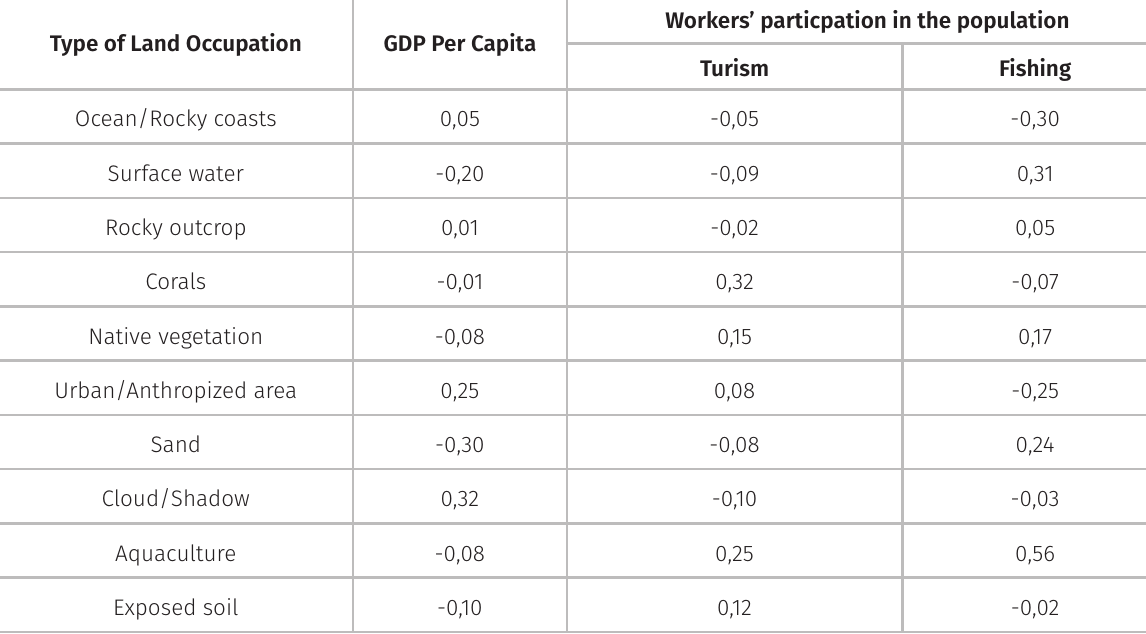
Table II. Correlation between socioeconomic variables and the shares of each land cover type.